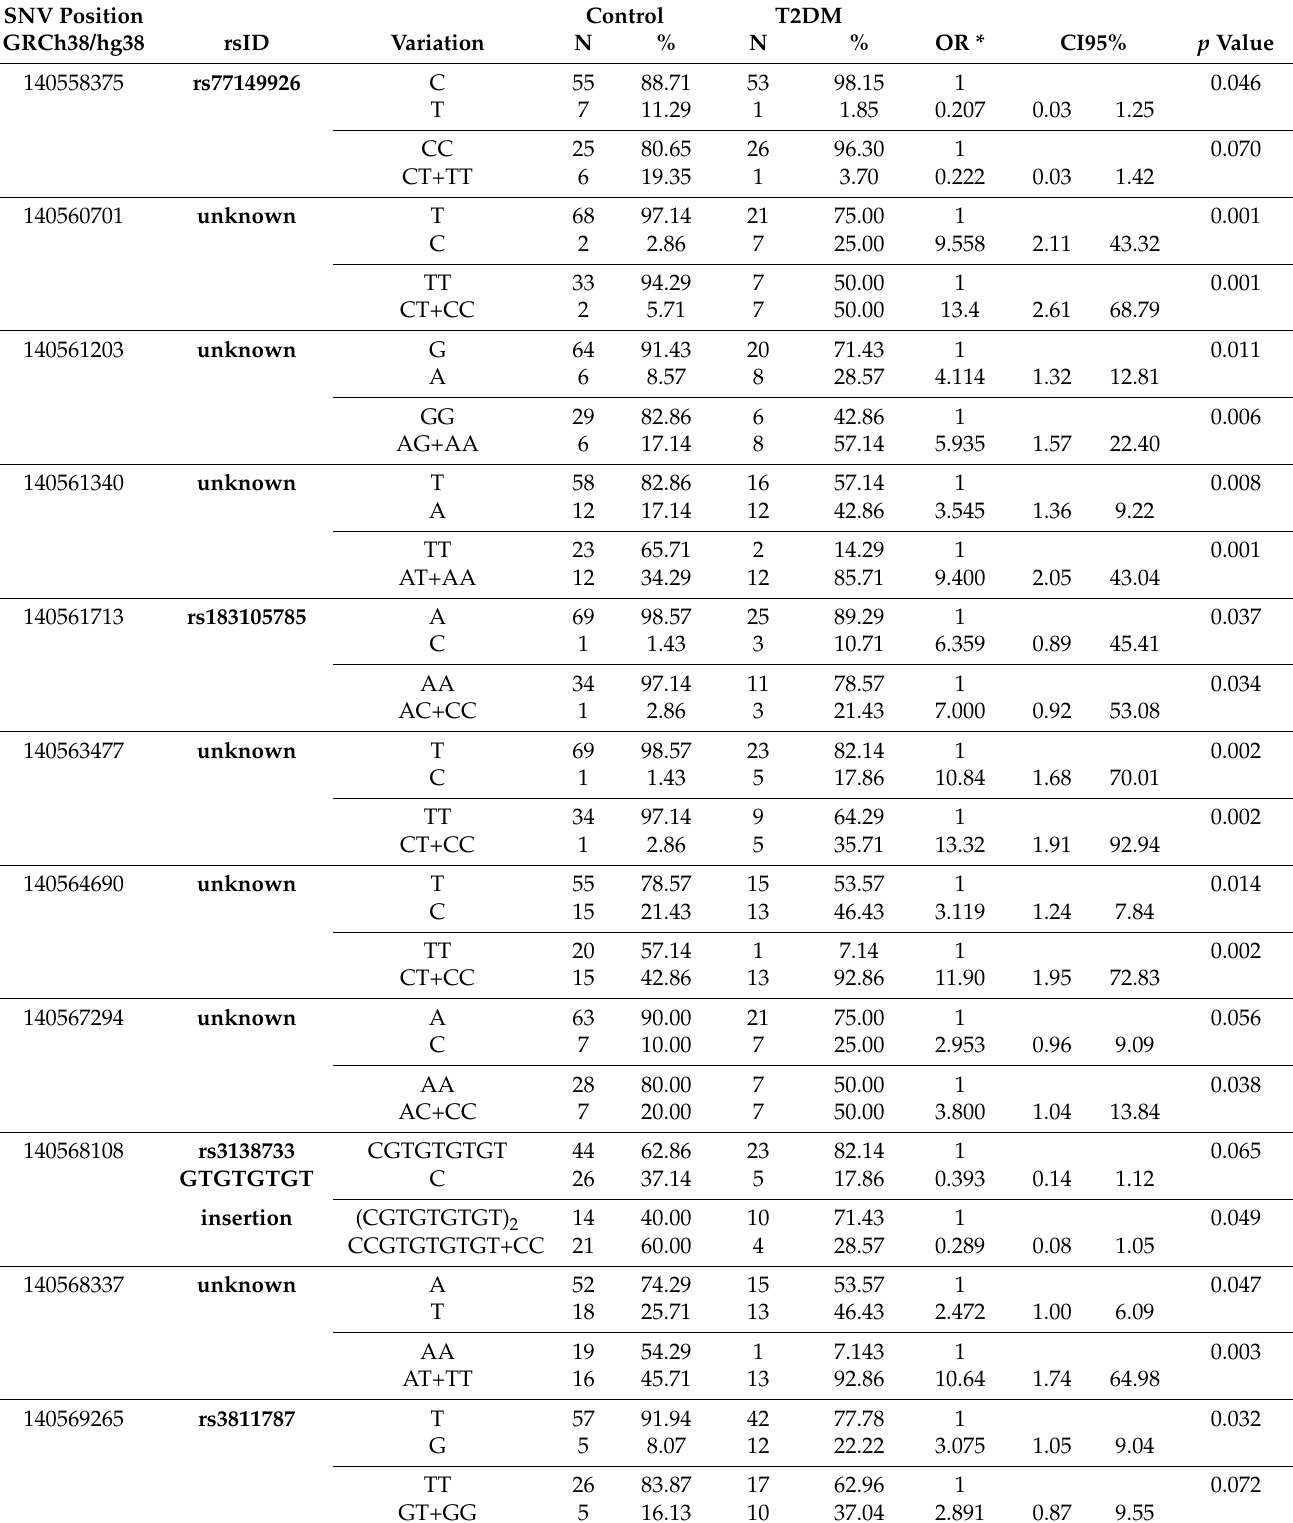
Table 3. Selected variants of the UCP1 gene with the different frequencies of alleles and genotypes between controls and MetS with T2DM